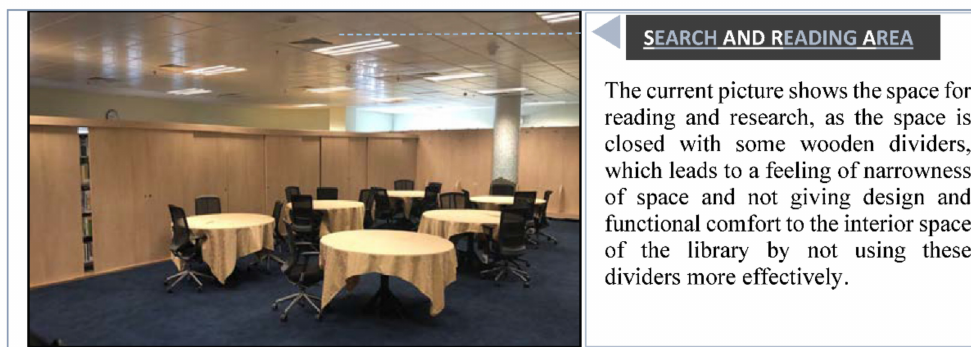
Figure 17. The interior design of the reading hall space contains tables and computers for online search and storage units for books and internal borrowing.